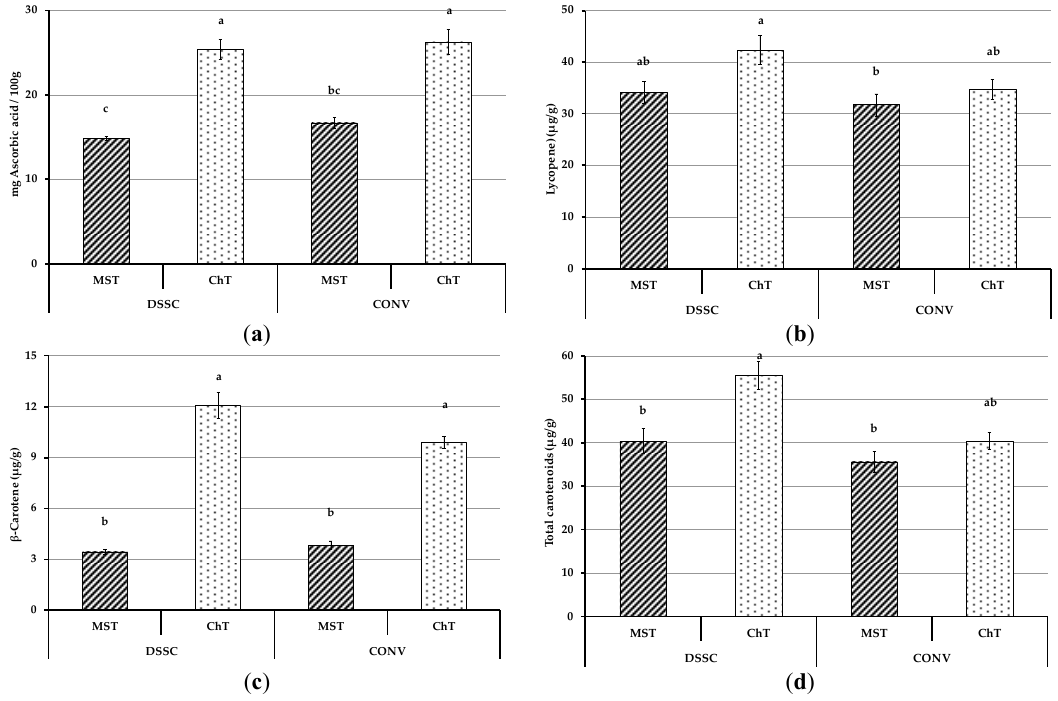
Figure 7. Content of bioactive ingredients of the fruits of the two tomato hybrids [MST (medium-sized) and ChT (cherry)] in the two greenhouses [DSSC (Dye-Sensitized Solar Cell) and CONV (Conventional)]: ( a ) ascorbic acid; ( b ) lycopene; ( c ) β -carotene; and ( d ) total carotenoids. Bars with different letters were significantly different by LSD at P ≤ 0.05.